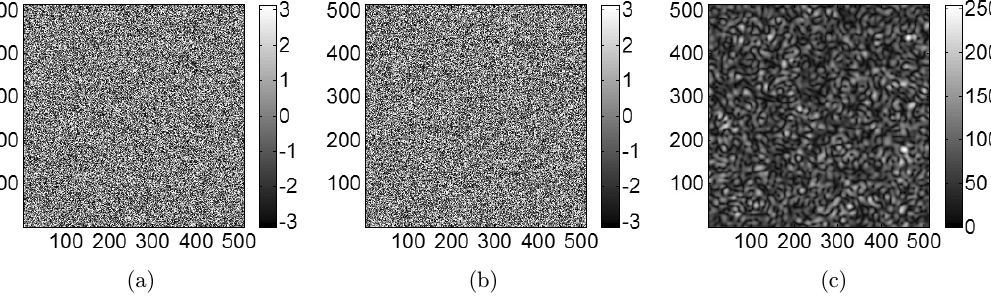
Fig. 6. The phase pro¯le retrieved by G – S algorithm at P1 plane, and its di®ractive ¯eld at its Fourier plane P2. P1 and P2 refer to the corresponding planes shown in Fig. 3. (a) The phase retrieved by the G – S algorithm at P1 plane. (b) The phase at P2 plane by Fourier transforming the phase in (a). (c) The amplitude at P2 plane by Fourier transforming the phase in (a). The units of the gray bars are radians in (a) and (b), and the normalized standard grayscale in